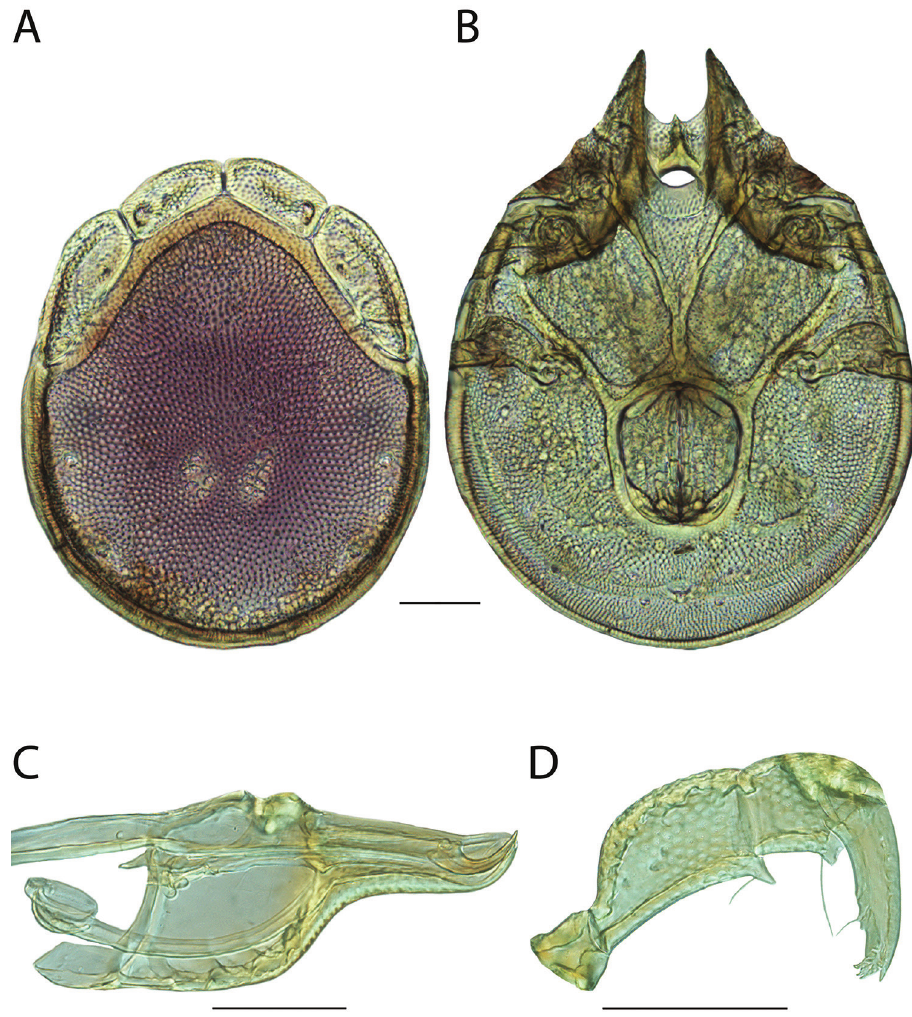
Figure 222. Torrenticola regalis sp. n. male: A dorsal plates B venter (legs removed) C subcapitulum D pedipalp (setae not accurately depicted). Scale = 100